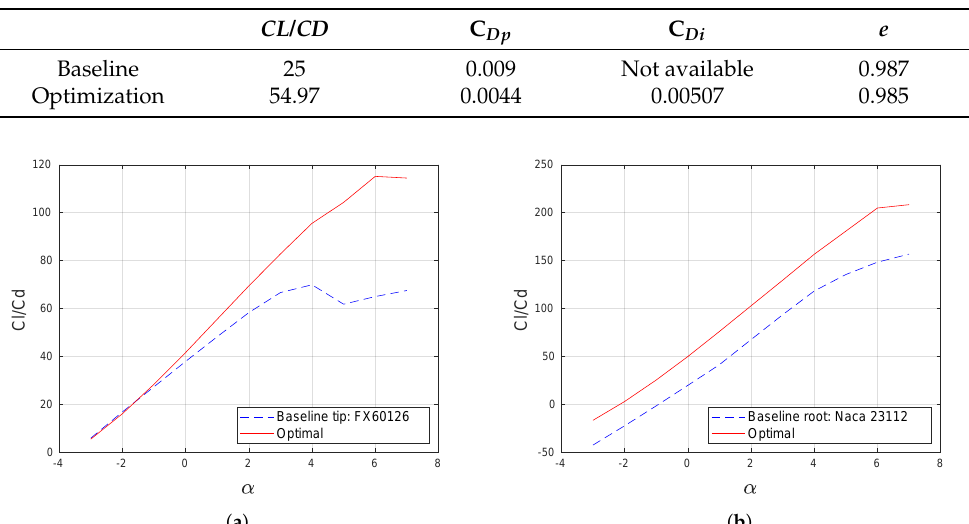
Table 3. Comparison of aerodynamics between baseline and optimization.